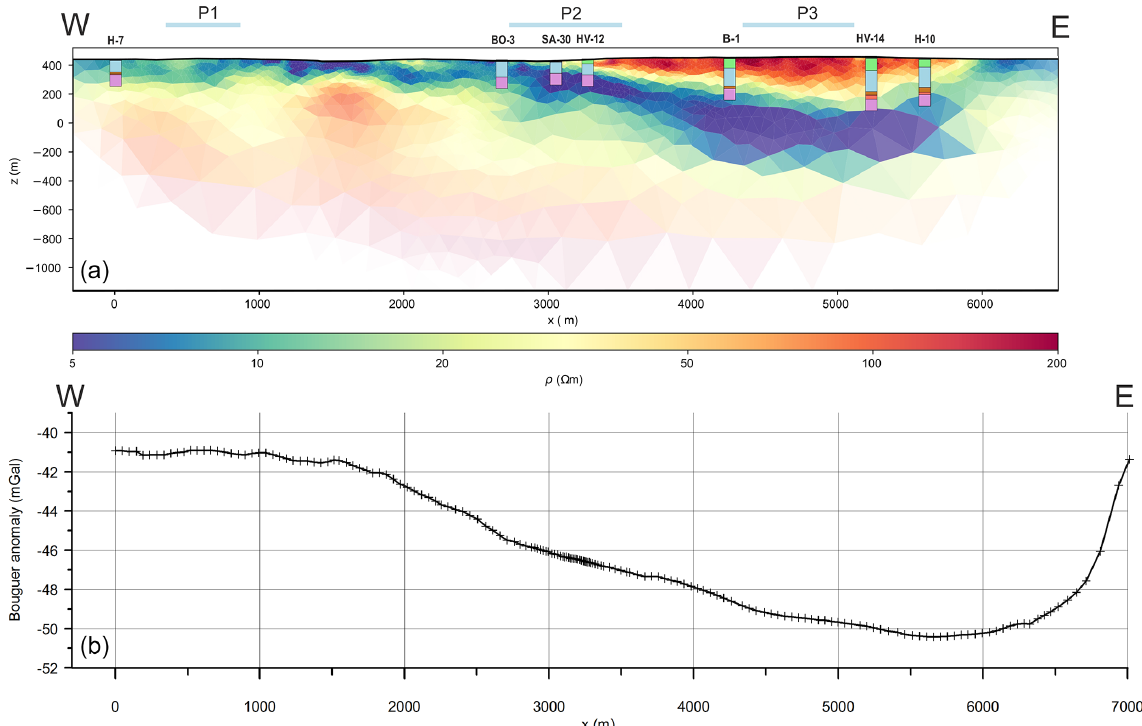
Figure 7. Inversion result (resistivity distribution) of the large-scale profile with the lithology columns of the boreholes (a) and the Bouguer gravity (b) ( z : ma.s.l). Colors for each stratigraphic unit are identical to Fig. 2: green – Vildštejn formation, light blue – Cypris formation, brown – coal, red – Lower Sand formation, pink – phyllitic–granitic basement. The relative RMS is 14.5%, and coverage-based alpha shading is used as in Fig.